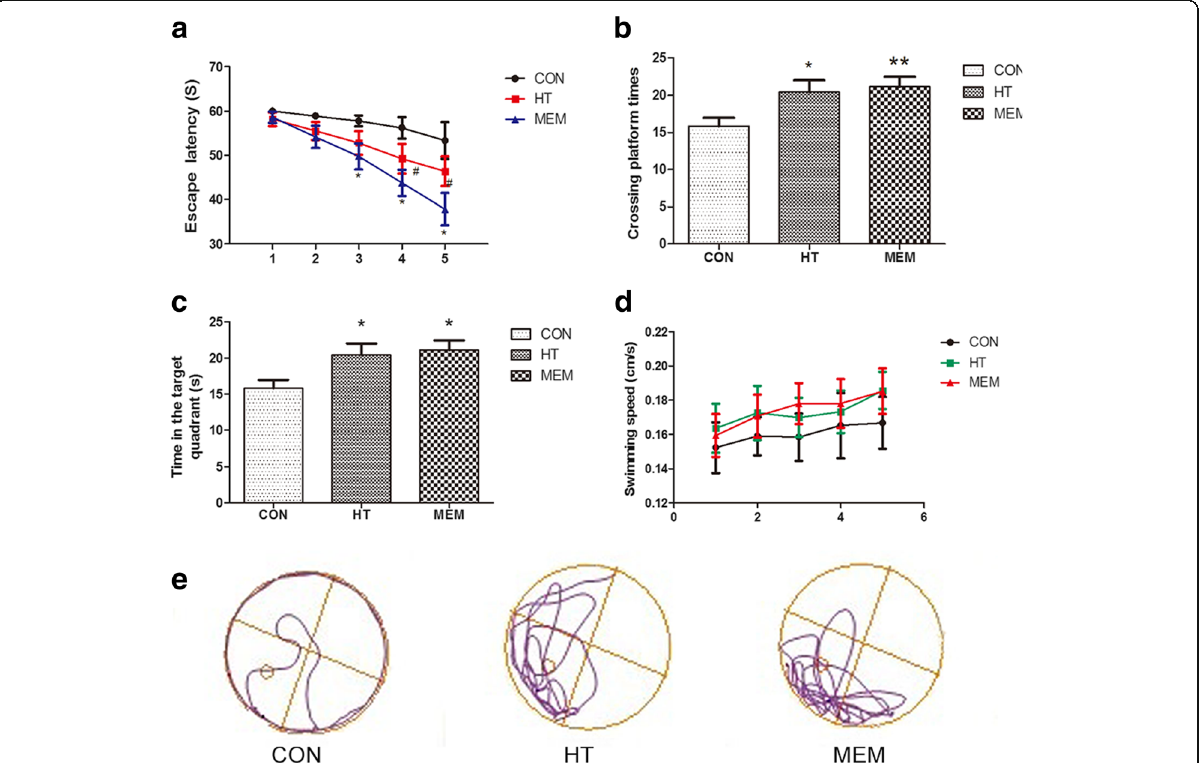
Fig. 1 HT Ameliorates Learning and Memory Deficits in APP/PS1 Transgenic Mice. HT improves cognitive impairment in APP/PS1 Transgenic Mice. a Escape latency for escape to the submerged platform in the probe trails. b Crossing platform times in the probe trails. c The time in the target quadrant. d Swimming speed in the training trails. e The track of probe test. Data are presented as the mean ± SEM ( n = 15). * P < 0.05, ** P < 0.01, compared with control group; # P < 0.05, compared with control group. One-way ANOVA followed by post hoc Bonferroni ’ s test; * P < 0.05 compared with control group, # P < 0.05 compared with control